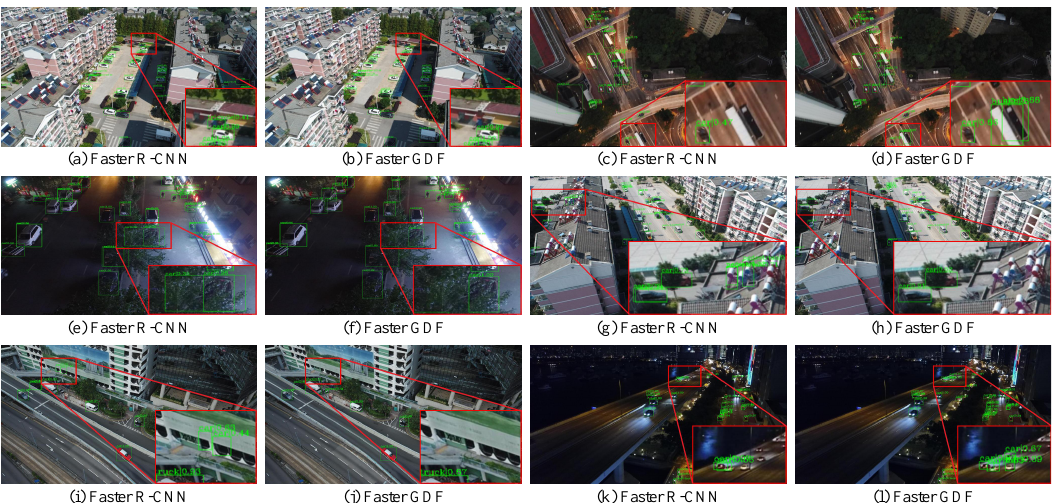
Figure 5. Selected examples of detection results based on the Faster R-CNN and the proposed Faster GDF approach. Compared with results from Faster R-CNN, the proposed Faster GDF detects more objects in dense distribution with lower False